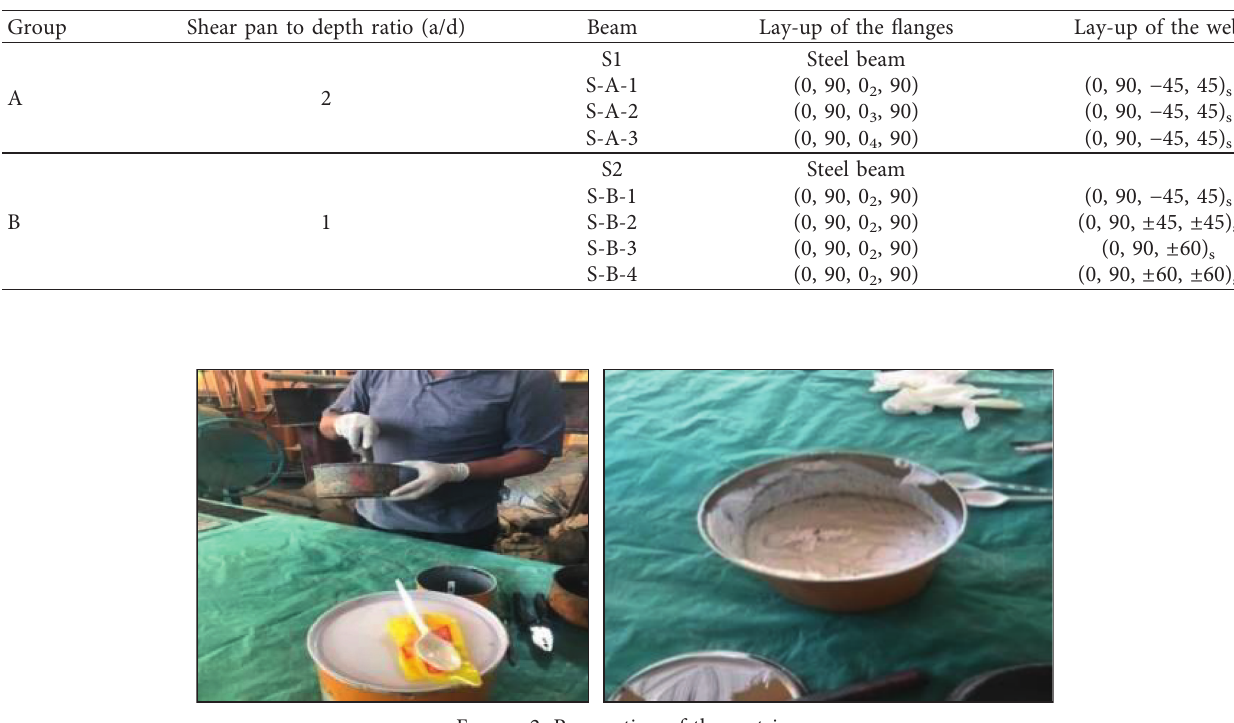
Table 1: Detailed information about the specimens.